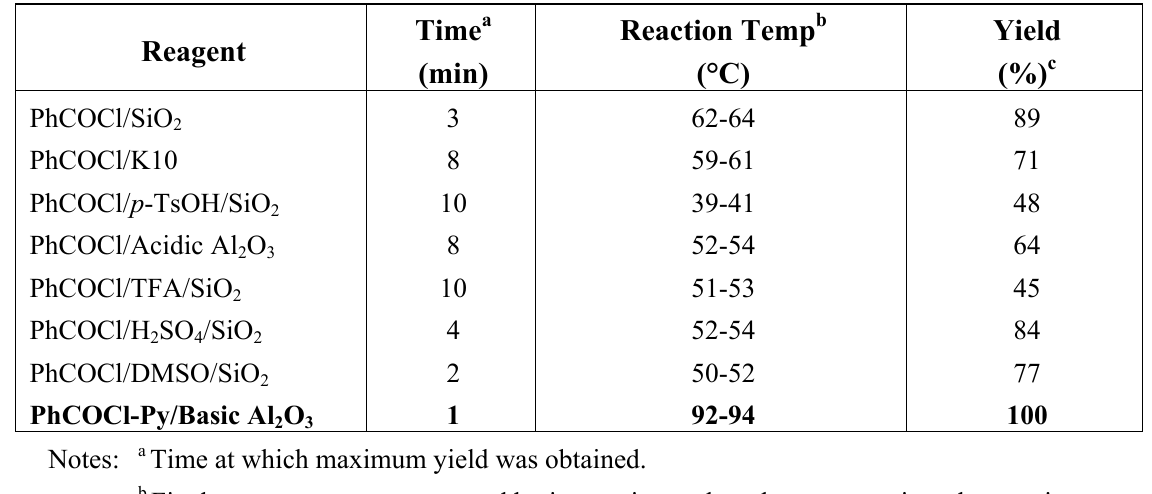
Table 1 . Preparation of benzanilide from aniline using various reagents (power=300